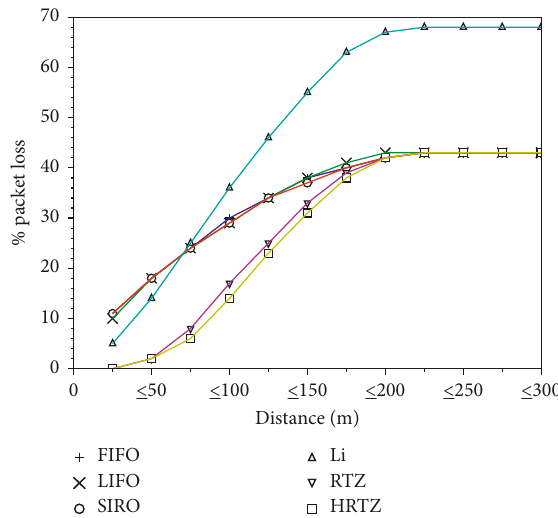
Figure 8: The cumulative percentage of packet loss with respect to distances between transmitting and receiving vehicles.